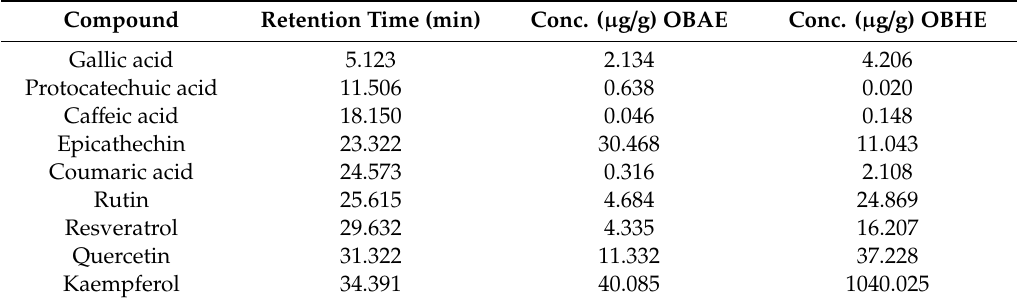
Table 2. The main polyphenolic content of basil hydro-alcoholic extracts (OBAE and OBHE) analyzed by